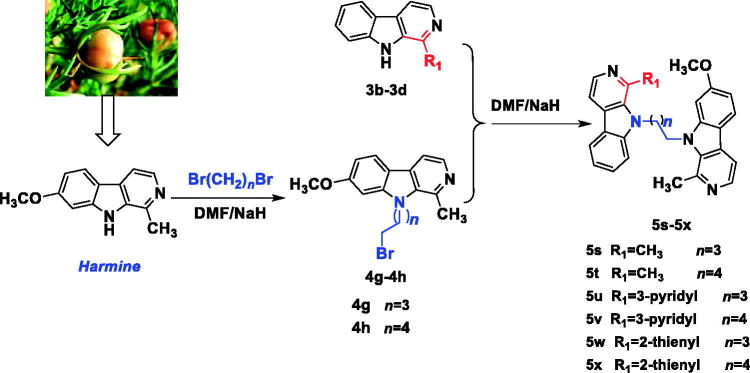
Synthesis of the N9-heterobivalent β-carbolines 5s-x.